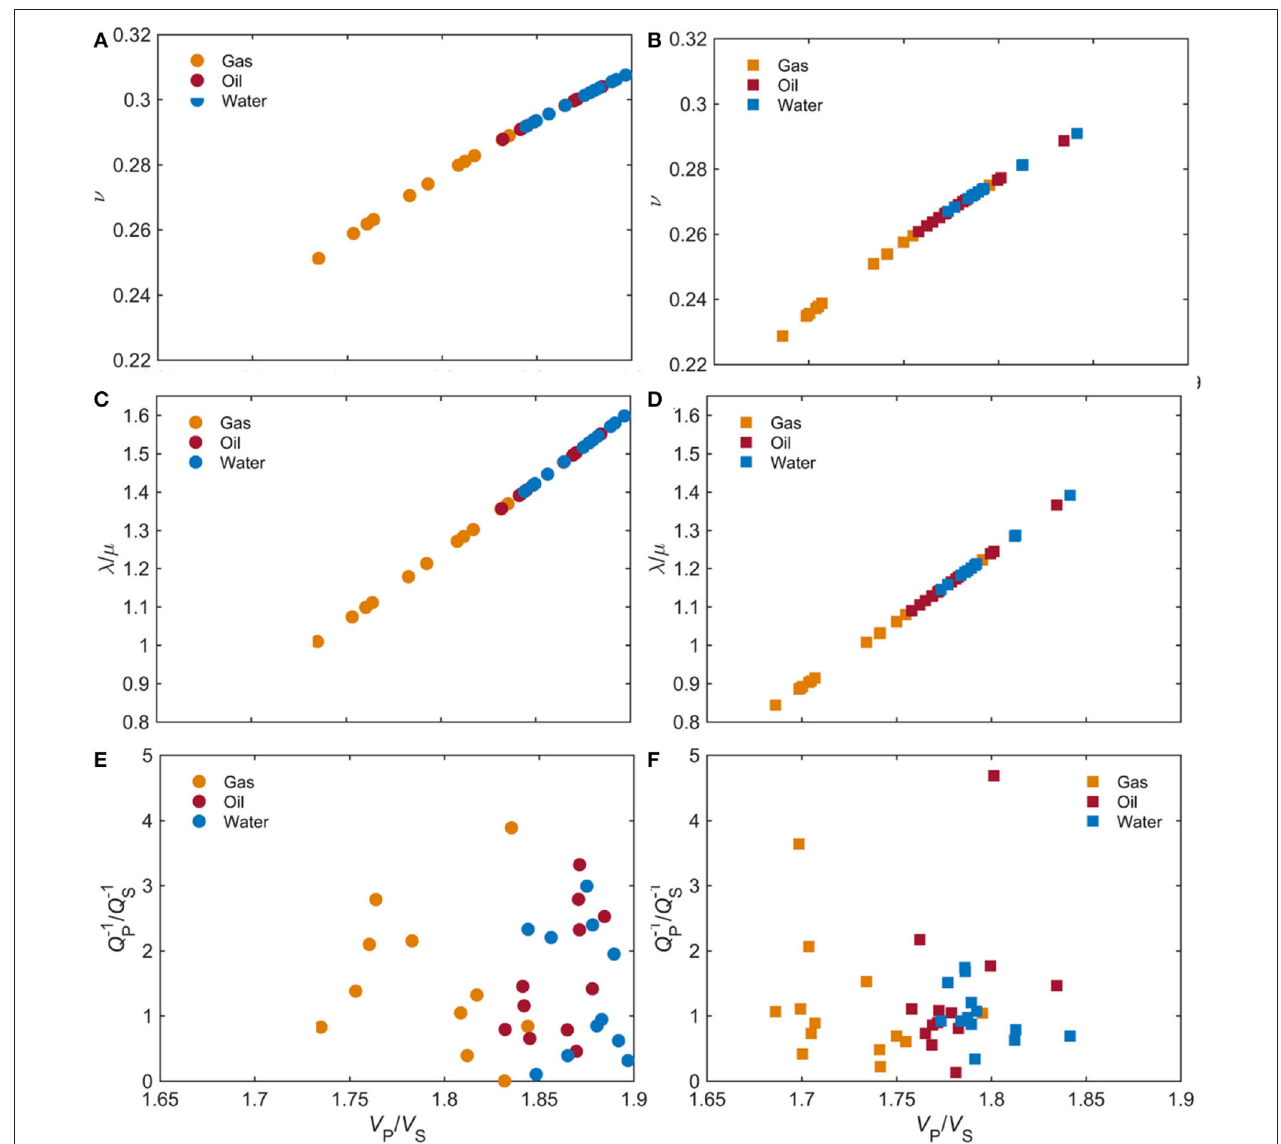
FIGURE 4 | Crossplots of ν – V P / V S , λ/µ – V P / V S , and Q − 1 P / Q − 1 S – V P / V S for siltstones (A,C,E) and dolomites (B,D,F) (see Figure 3 for the explanations).